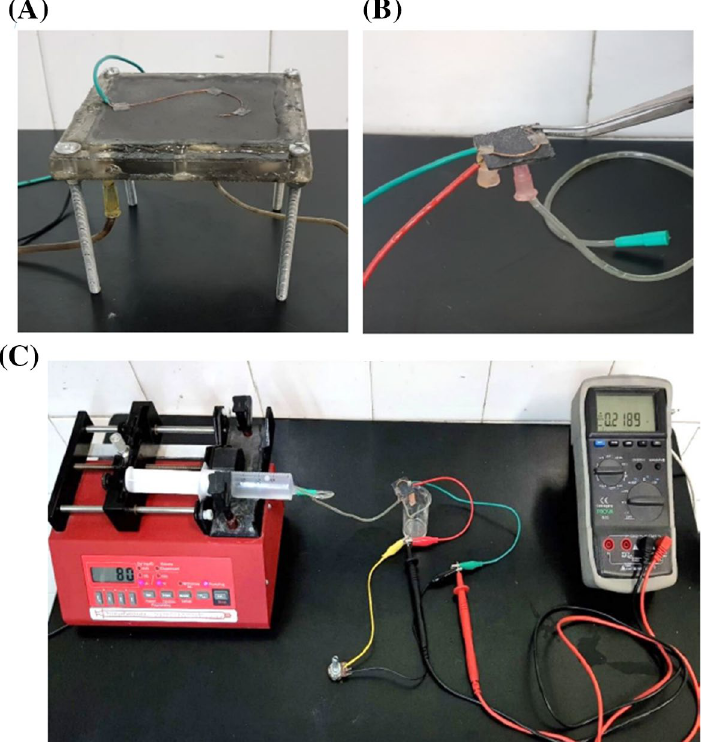
Figure 2. ( A ) the macro-scale and ( B ) micro-scale MFCs, made in this research. ( C ) Measuring the potential difference of the micro-sized MFC in the presence of variable resistance in the